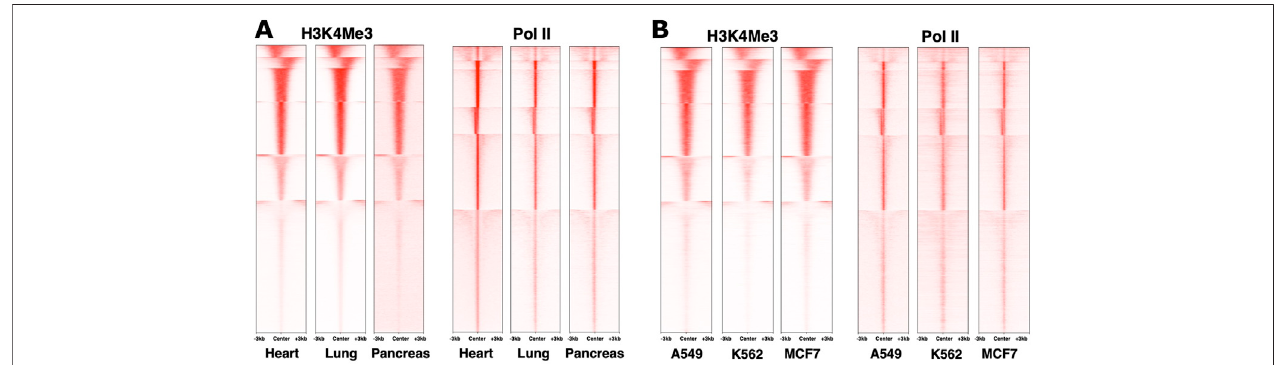
FIGURE 1 | Similarity in genome-wide distributions of Pol II and histone marks across distinct systems. ChIP-sequencing datasets from the ENCODE database (Davis et al., 2018) for human heart, lung and pancreas normal tissues (A) and A549, MCF7 and K562 cancer cell lines (B) were used to plot density heatmaps around peak regions ± 3 kb from a peak center using computeMatrix reference-point (version 3.3.0) and plotHeatmap (version 3.3.0) with k-means clustering (k (cid:1) 6). The numbers of peaks are 22,944 for Pol II and 28,287 for H3K4Me3. The datasets used were ENCSR901SIL, ENCSR701FGA, ENCSR876DCP,